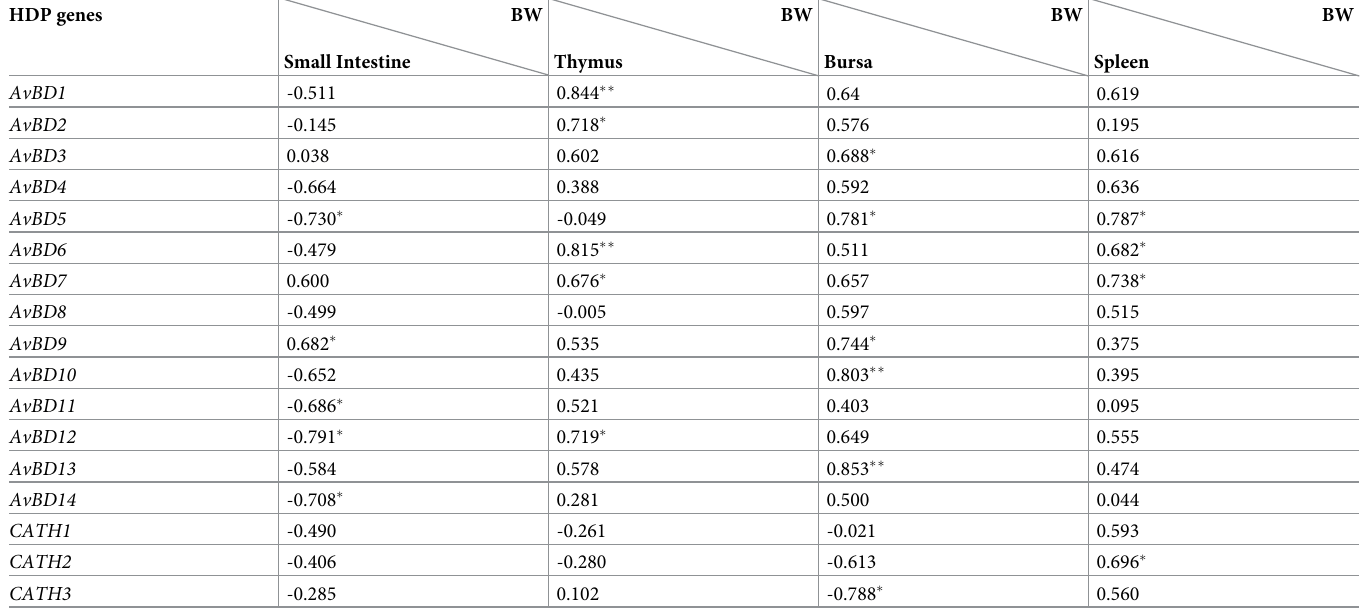
Table 3. Correlations between the body weight (BW) and mRNA expression of HDP genes in different organs. HDP